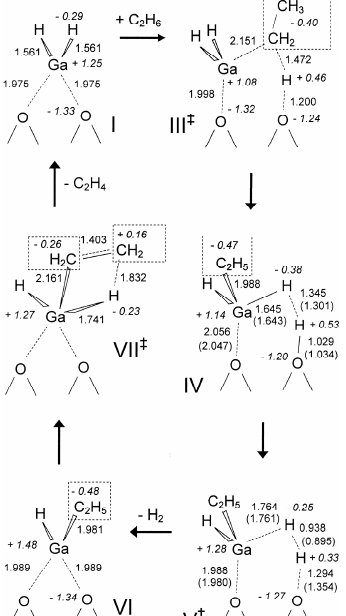
Figure 9. Reaction route for “alkyl” activation of ethane on [GaH 2 ] + . Reprinted with permission from ref [117]. Copyright 2000 American Chemical Society.